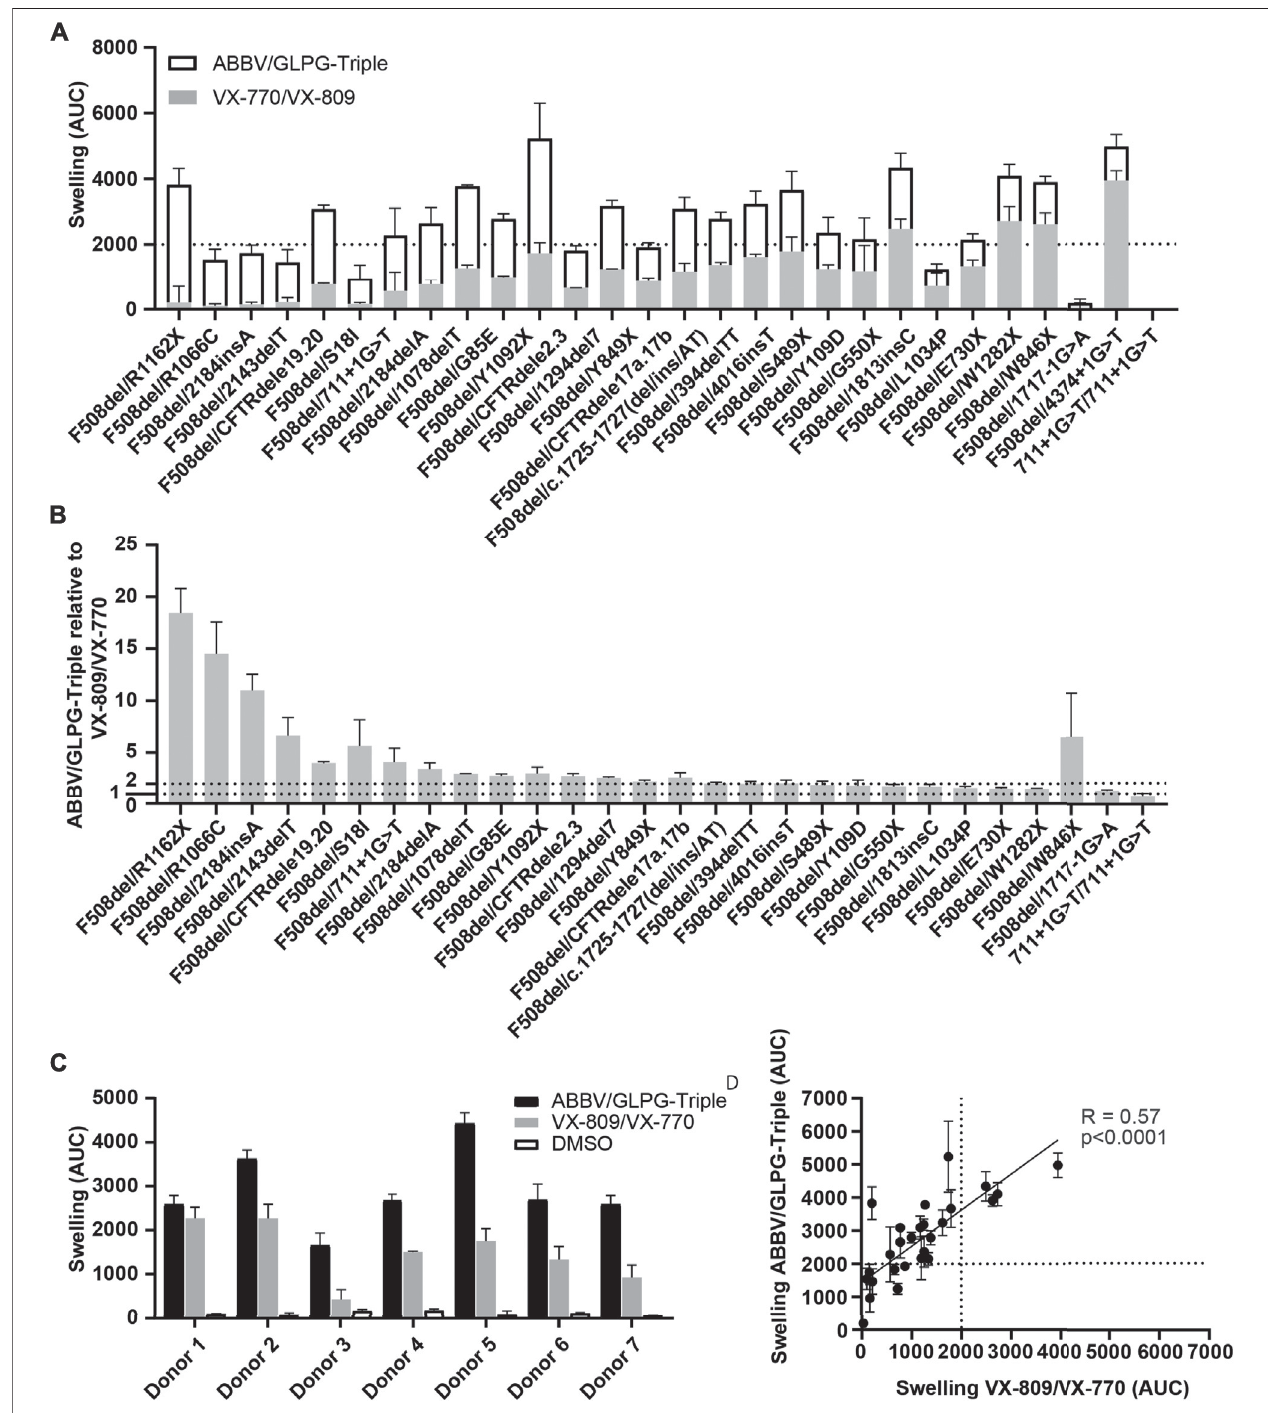
FIGURE 2 | FIS response of F508del/minimal function organoid cultures upon ABBV/GLPG-Triple therapy. (A) FIS response upon VX-770/VX-809 (3 μ M, gray bars) and Abbvie-Triple (ABBV/GLPG-2222 3 µM + GLPG/ABBV-2737 3 µM + ABBV/GLPG-2451 3 µM,white bars, stacked) treatment, corrected for the DMSO condition.n (cid:1) 3,eachbarrepresentsmean+SD.CFTRcorrectorswereadded24hpriortoFISmeasurements,CFTRpotentiatorsweresimultaniouslyaddedwith5 µM FSK. (B) FIS reponse upon the ABBV/GLPG-Triple (3 µM) relative to VX-770/VX-809 (3 µM) treatment, both corrected for the DMSO condition. n (cid:1) 3, each bar representsmean+SD.Similarrawdatawasusedin (AandB) ,yetdifferentiallyillustrated. (C) FISresponseofsevenF508del/F508delorganoidculturesupontreatment with ABBV/GLPG-Triple (ABBV/GLPG-2222 1 µM + GLPG/AB- BV-2737 1 µM + ABBV/GLPG-2451 1 µM) or VX-809/VX-770 (1 µM) and 0.8 µM FSK. n (cid:1) 3, bars represent mean + SD. (D) Correlation of FIS responses upon the ABBV/GLPG-Triple (3 µM) and VX-770/VX-809 (3 µM) treatment, n (cid:1) 3, each datapoint represents mean ± SD.